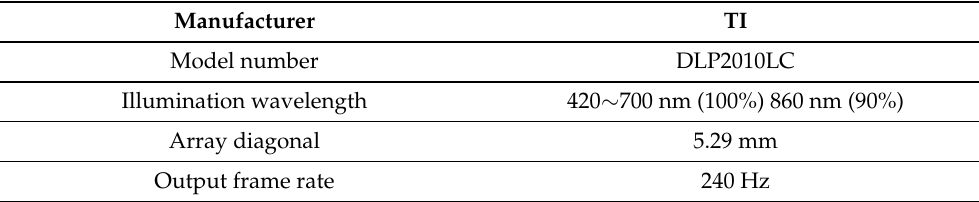
Table 2. DMD specification of GI-OCT.